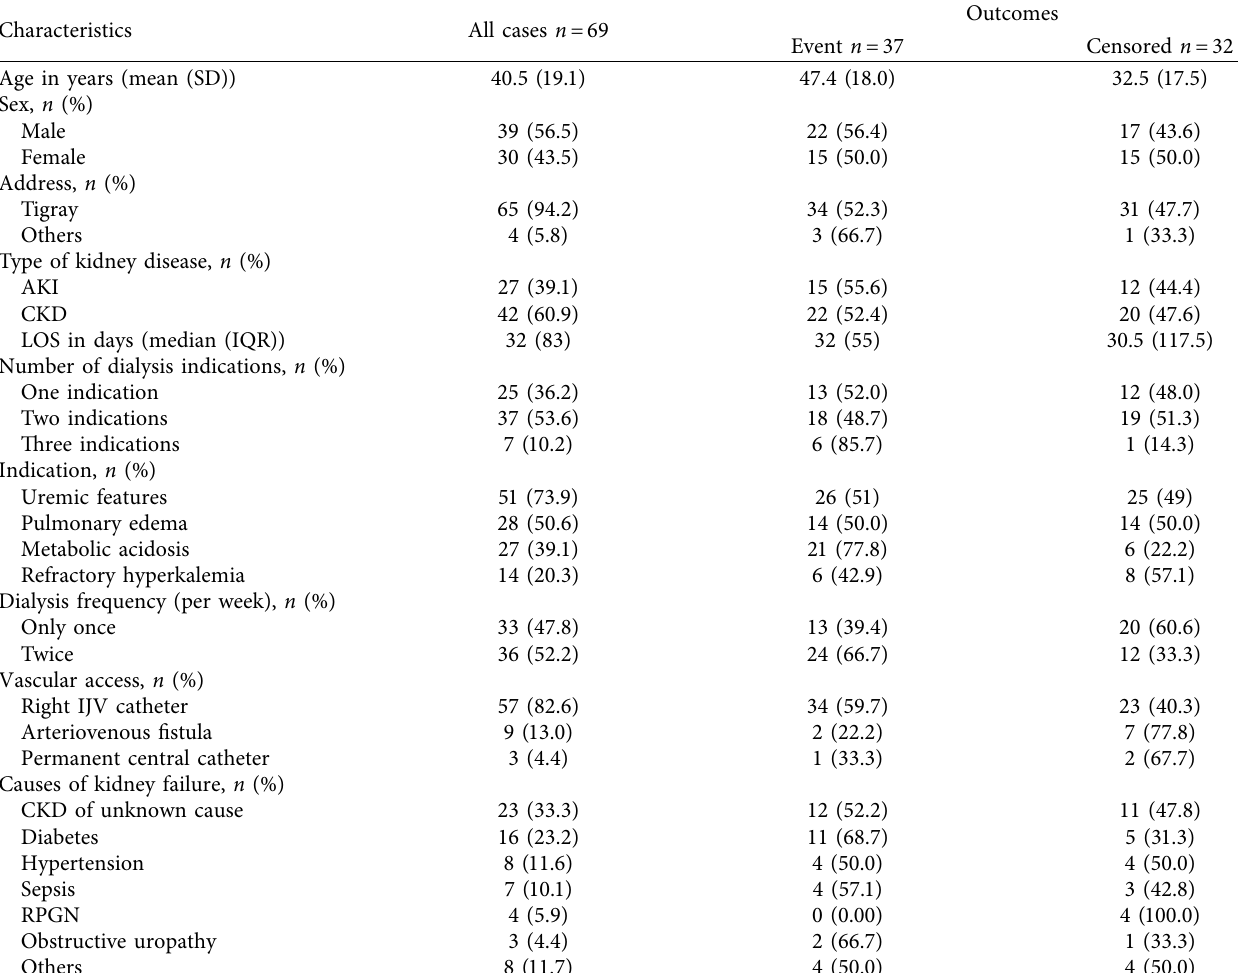
Table 1: Sociodemographic and clinical characteristics of the study participants, Ayder Comprehensive Specialized Hospital, Mekelle, Northern Ethiopia, 2021 ( n � 69).